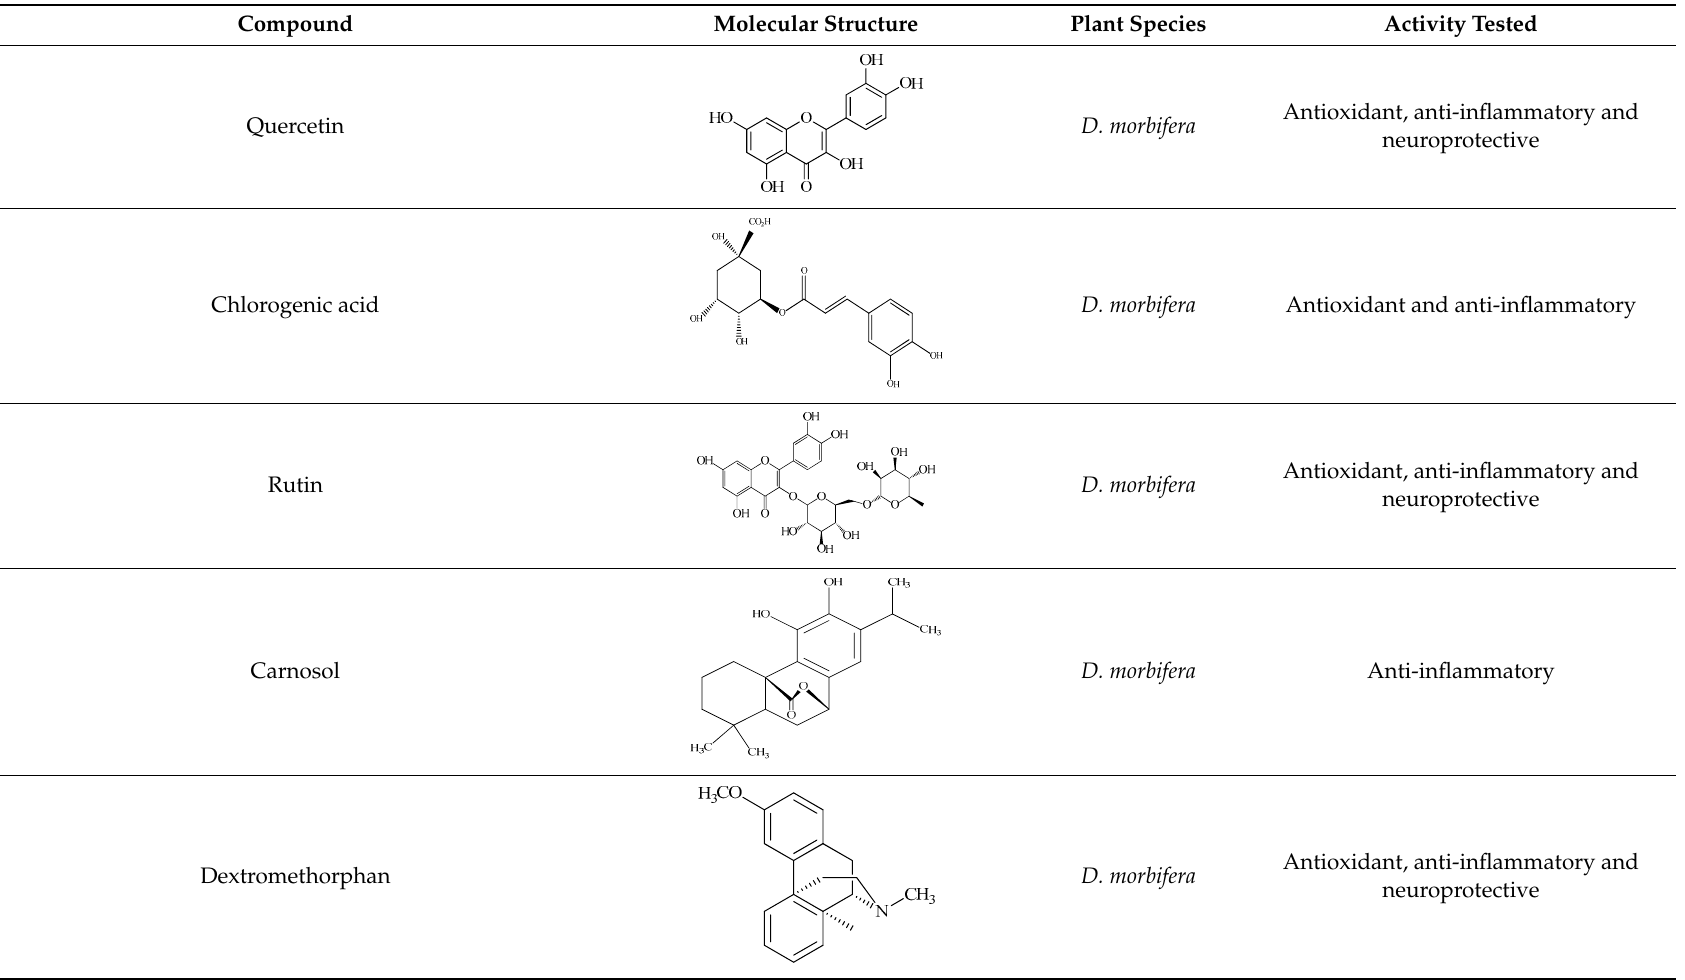
Table 2. The main bioactive compounds of D. morbifera and its pharmacological